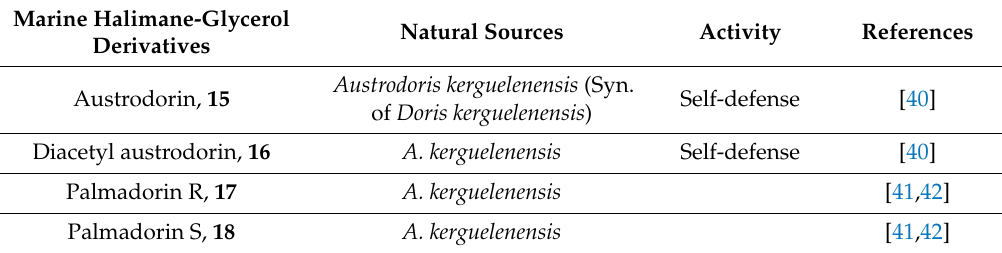
Figure 6. Halimane-glycerol derivatives. Table 2. Natural sources and activities of marine halimane-glycerols.